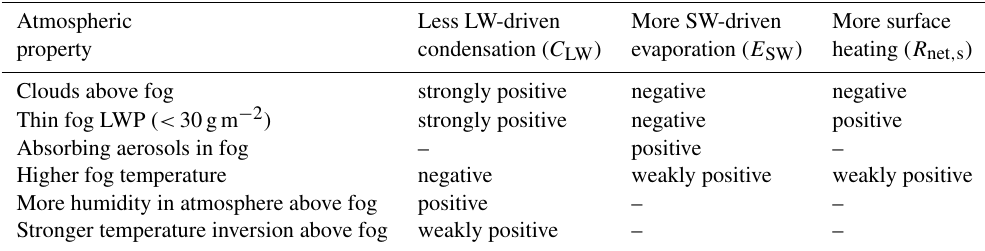
Table 5. Summary of how the susceptibility of fog to dissipation is affected by variability in atmospheric conditions through radiative processes. Positive (negative) means that the fog is more (less) likely to dissipate due to lower (higher) net production of liquid water by the indicated radiative process (defined in Sect. 2.1) due to the indicated atmospheric property. See text for details.